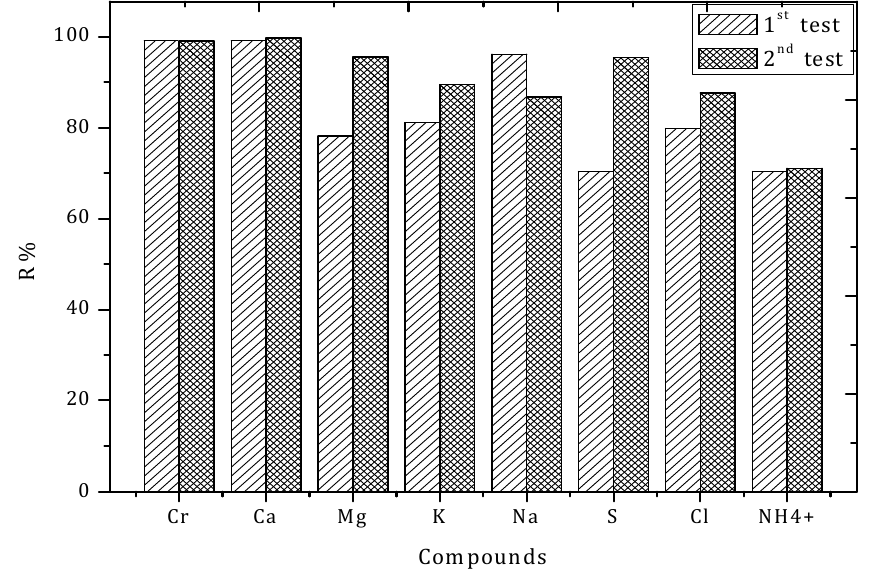
Figure 5. Apparent rejections for the target compounds obtained by filtration of real tannery wastewater across SW30 membrane.